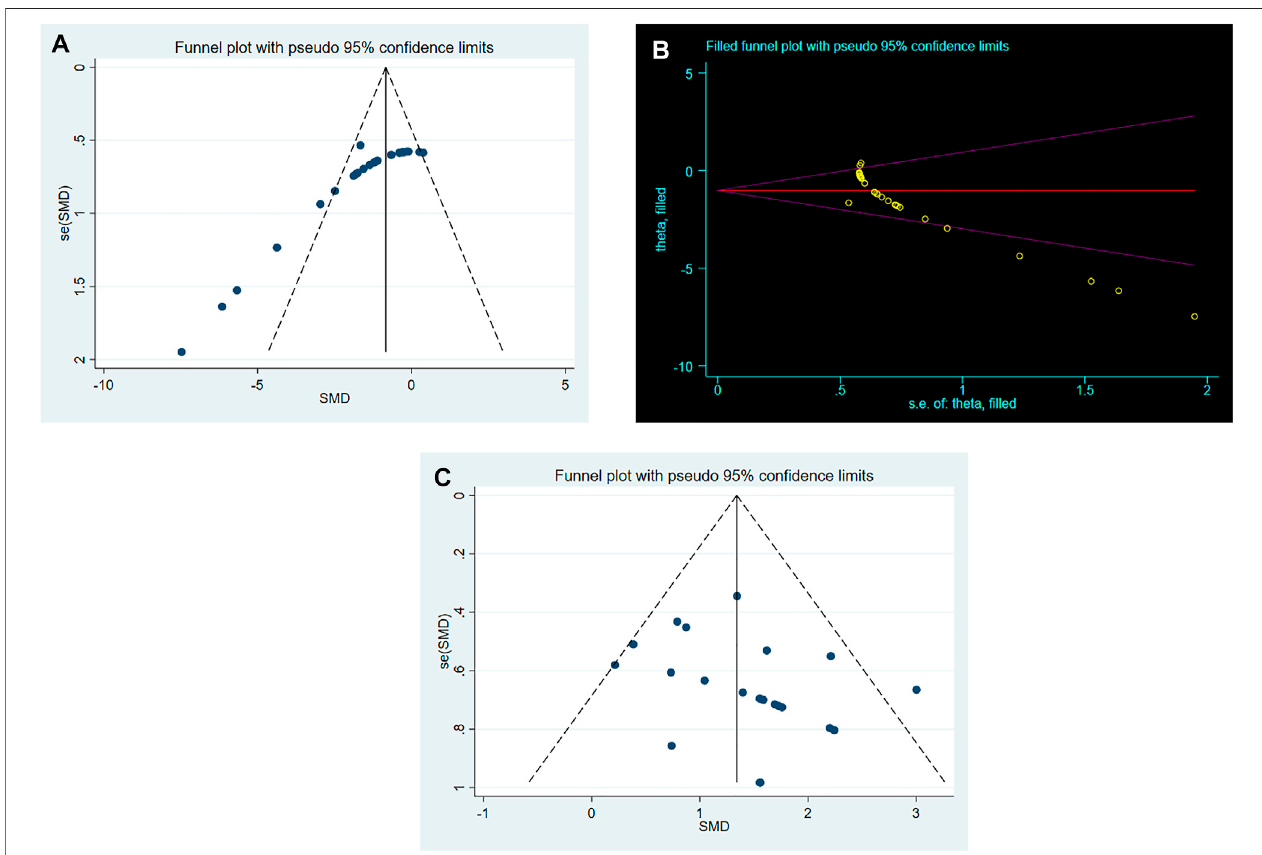
FIGURE 4 | (A) . Funnel plots for RES treatment of BWC. (B) . Trim-and- fi ll analysis of RES treatment of BWC. (C) . Funnel plots for RES treatment of